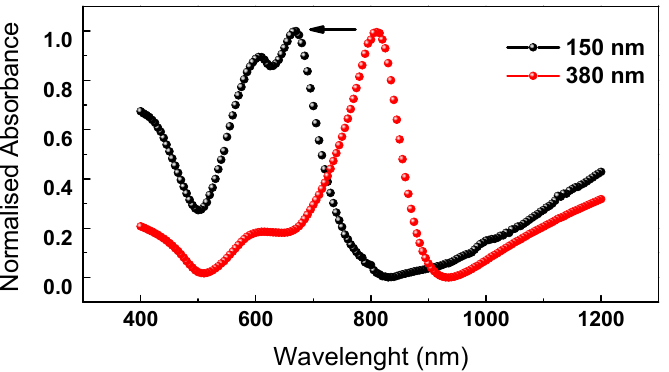
Figure 7. Normalized absorbance spectra in the 400–1200 nm spectral range of long-range ordered distributions of NHA characterized by different holes diameter and realized in 30 nm thick Au layer.